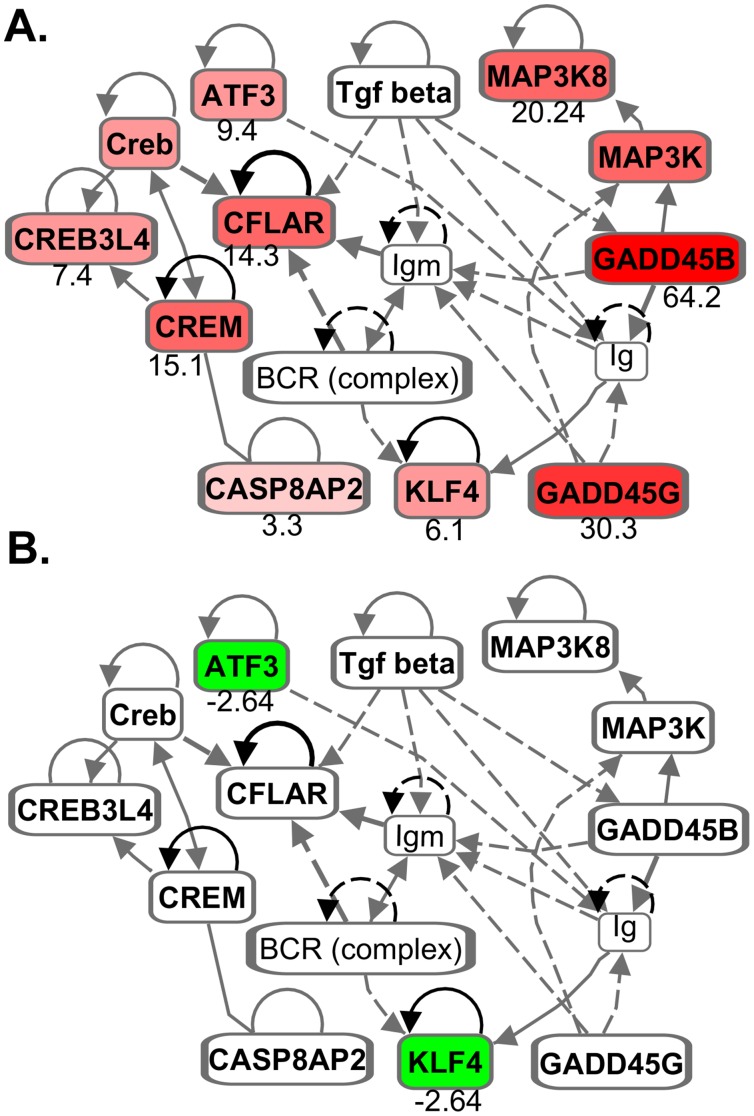
Signaling pathways involving growth arrest and DNA damage inducible genes.Various genes (e.g. GADD45B 64.156 fold; GADD45G, 30.299 fold; MAP3K8 20.242 fold etc.), up-regulated in Rh-BMDMs in response to Mtb-H (A) are down-regulated in Rh-BMDM infected with Mtb-A (B). Grey lines represent multiple steps. ATF3-Activating transcription factor 3; CREB-cAMP response element-binding protein; CREM-cAMP response element modulator; KLF4-Kruppel like factor 4 that interact with CREB-binding protein [43]; CFLAR- CASP8AP2 and FADD like receptor. Figures were made using Ingenuity IPA software (Ingenuity Systems, Inc. USA).